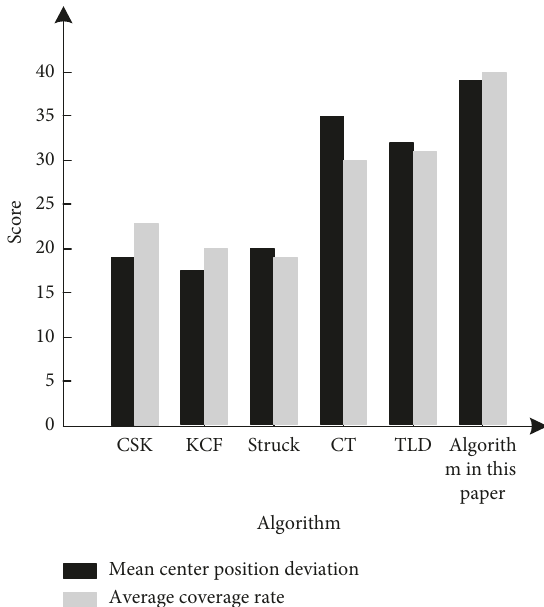
Figure 1: Performance comparison between average center position deviation and average coverage rate of different algorithms.